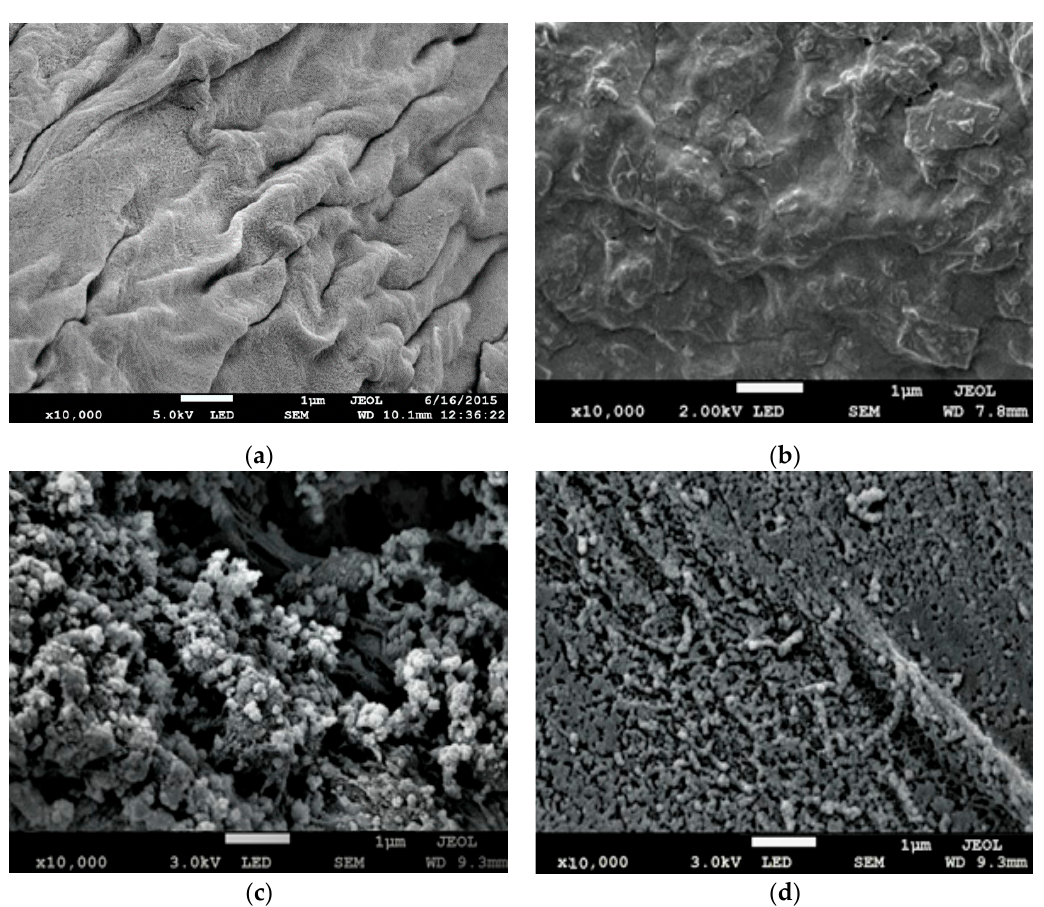
Figure 3. FE-SEM micrograph of ( a ) jute cellulose, ( b ) PMA-grafted cellulose, ( c ) poly(hydroxamic acid) ligand and ( d ) poly(hydroxamic acid) ligand-copper complex.